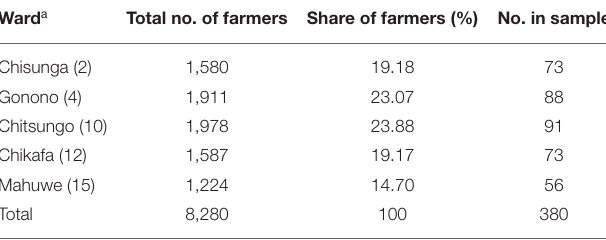
TABLE 1 | Ward composition and farmer